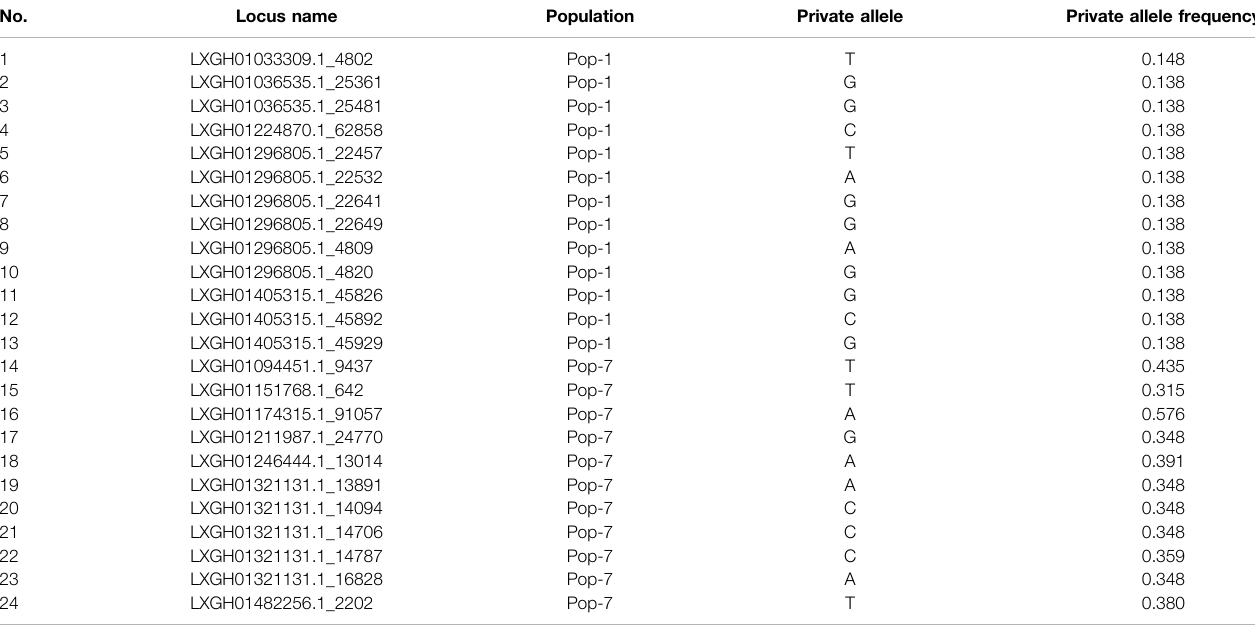
TABLE 2 | List of SNP loci with a private allele in Pop-1 and Pop-7 with their alleles and allele frequencies. No.